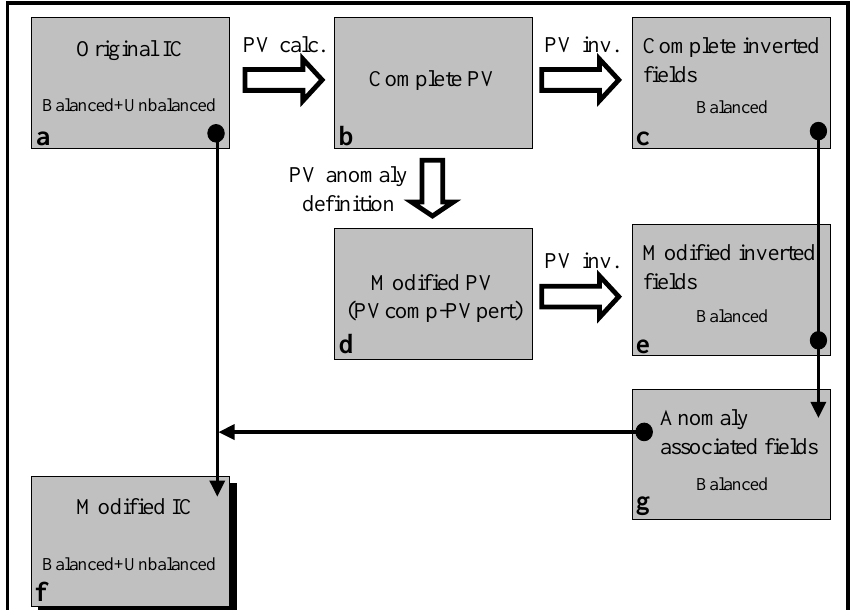
Fig. 14. Diagram showing the process of initial conditions modification using the PV inversion technique. Labels in- dicate the references to the process in- cluded in the